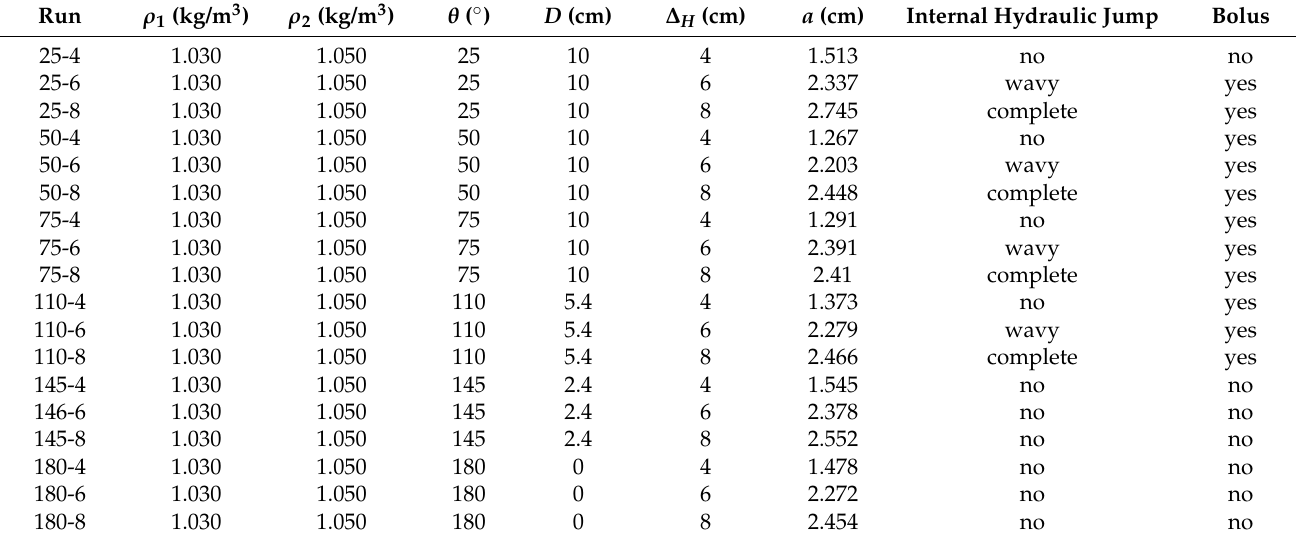
Table 1. Experimental conditions and relevant parameters.